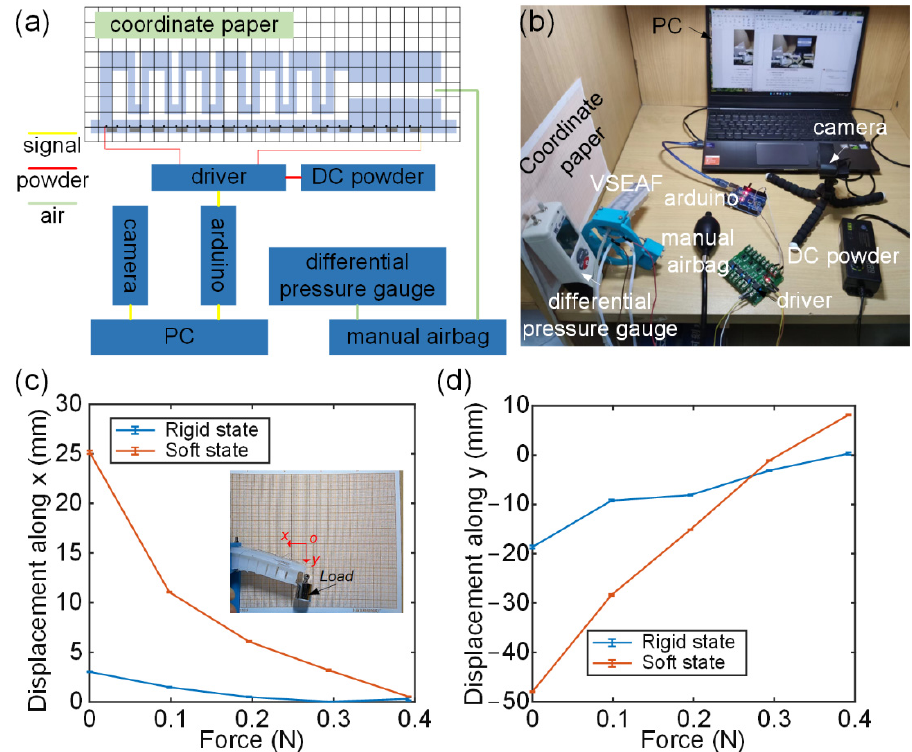
Figure 7. Stiffness performance test rig: ( a ) system diagram of the stiffness performance test, ( b ) the physical setup, ( c ) VSEAF displacement along the x -axis under varied loads, ( d ) VSEAF displacement along the y -axis under varied loads.